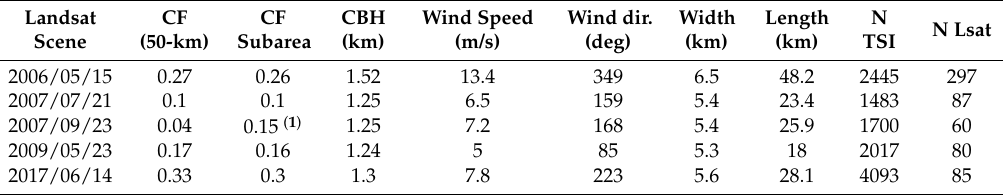
Table 1. Landsat cloud fraction (CF), cloud base height (CBH), wind speed and direction (dir.) at CBH, the estimated width and length of subareas (Figure 4b) for 130 ◦ FOV and 1-h averaging period. Numbers of clouds observed by TSI (N TSI) and Landsat (N